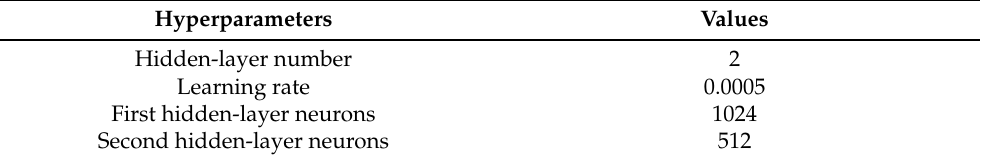
Table 2. HyMobLSTM model best hyperparameters values for random-search technique.